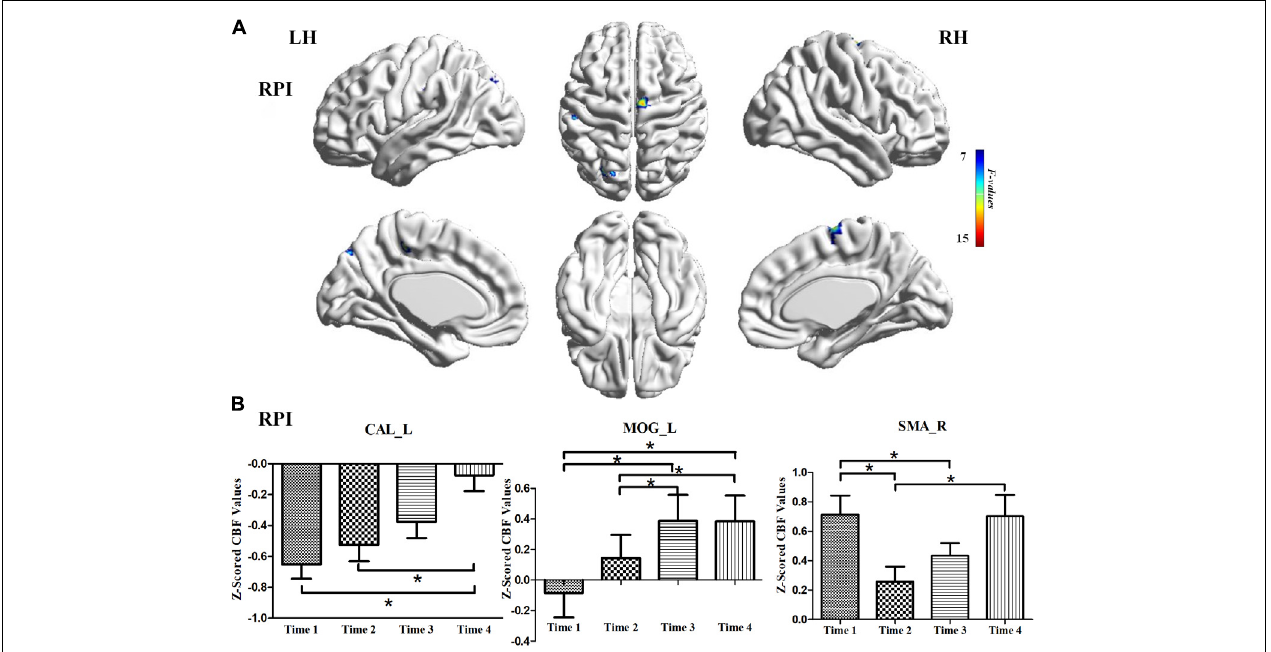
FIGURE 4 | CBF differences among different time-subgroups in the RPI group. (A) One-way repeated-measure ANOVA showed brain regions with CBF differences among different time-point subgroups in the CAL_L, MOG_L, and SMA_R. color bar indicated the F scores. (B) Bar plots showed the z -scored CBF values of these significant brain regions at four different time-subgroups and the change trends from the baseline stage to 6 months. CAL_L, the left calcarine sulcus; MOG_L, left middle occipital gyrus; SMA_R, right supplementary motor area; LH, left hemisphere; RH, right hemisphere; RPI, right pontine infarction. * P < 0.05.